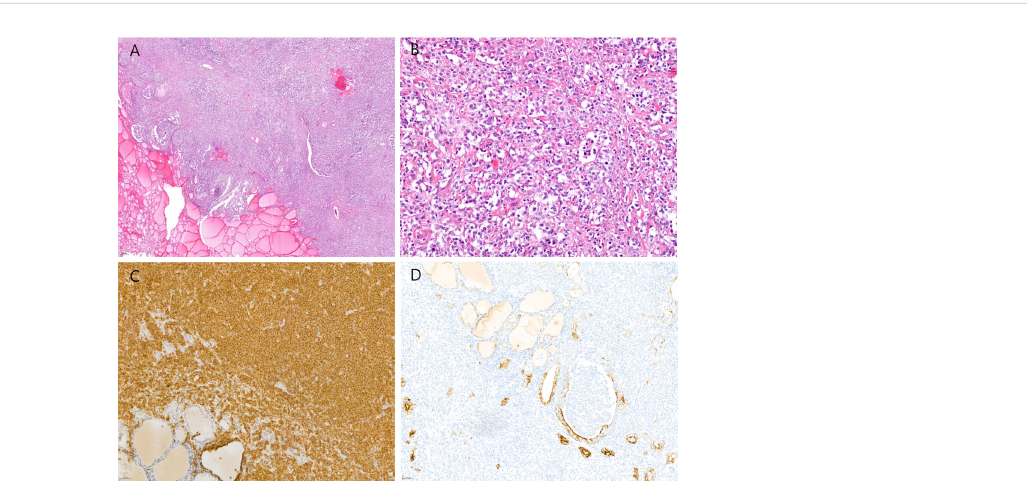
FIGURE 2 Histological features of diffuse large B cell lymphoma of the thyroid. (A) The thyroid gland is diffusely in fi ltrated by lymphoid cells (hematoxylin-eosin stain, original magni fi cation ×40). (B) The large lymphoma cells show vesicular nuclei with distinct nucleoli (hematoxylin-eosin stain, original magni fi cation ×400). (C) The tumor cells show strong and diffuse positive immunostaining for CD20 (original magni fi cation ×200). (D) The tumor cells have in fi ltrated into the thyroid follicular epithelium and lumen, con fi rmed by cytokeratin immunostaining (original magni fi cation